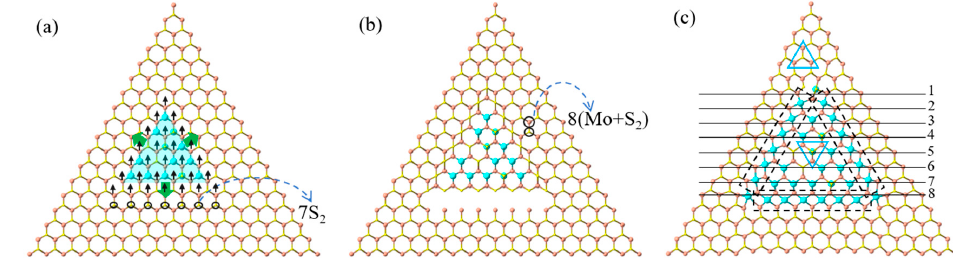
Figure 3. The atomic models of possible mechanisms forming an inversion domain and MTB. Mo, S, and Te are denoted by the salmon, yellow, and blue spheres, respectively. ( a ) The substitution of some S atoms by Te. The green arrows represent the compressive strain. The gilding of the Mo atom plane followed by the loss of S atoms to form S divacancy lines. ( b ) The loss of some Mo and more S atoms to further relax the strain. ( c ) More S atoms were substituted by Te and the formation of an inversion domain and MTB.